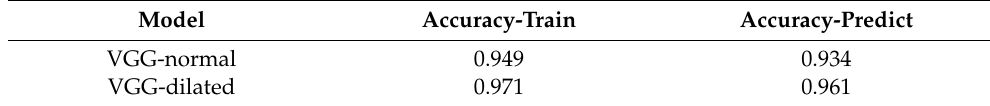
Table 3. Performance of VGG net models established by 2D spectral